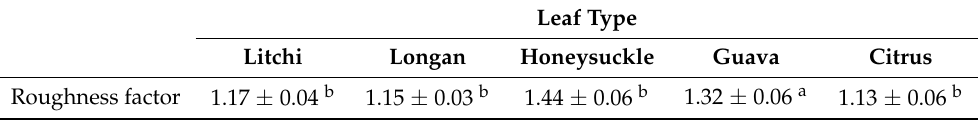
Table 1. The roughness factors for different leaf types.